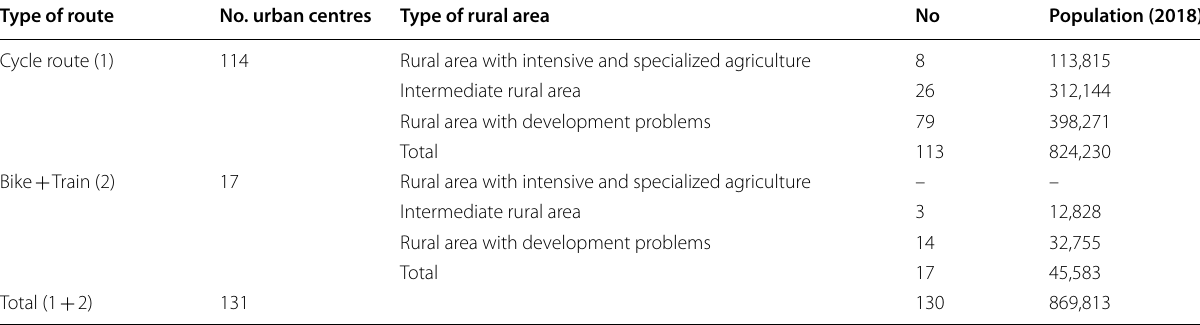
Table 2 Urban centres in rural areas crossed by the cycle network Type of route